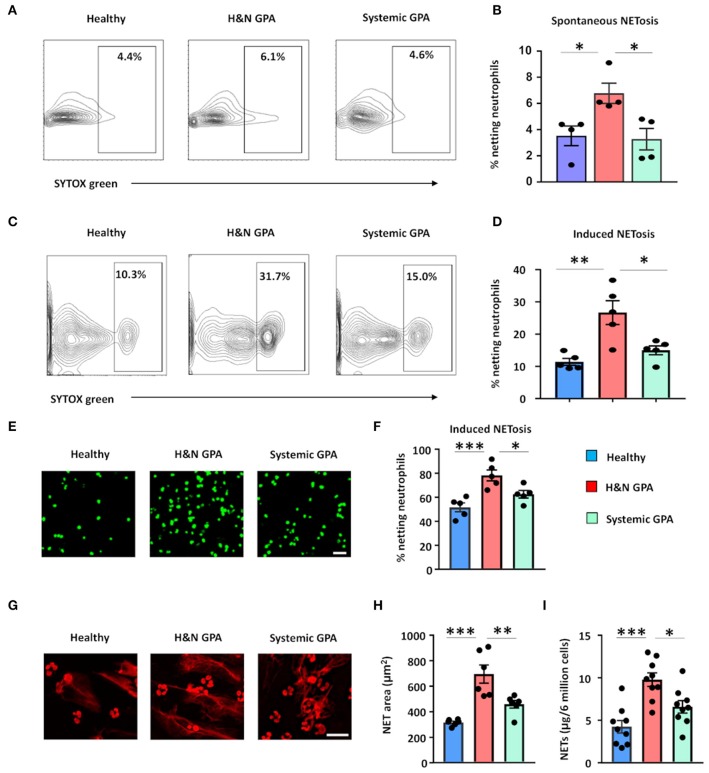
Neutrophil NET formation in patients with GPA correlates with clinical disease pattern. Blood was collected from patients with H&N GPA, systemic GPA, and age-matched healthy individuals. NET formation in isolated neutrophils was assessed by three methods. (A,B) Neutrophils were cultured for 1.5 h and spontaneous netting neutrophils were assessed as SYTOX® Green-positive cells by flow cytometry. Representative results (A) and data from four experiments (B). (C,D) Neutrophils were treated with phorbol myristate acetate (PMA; 20 ng/ml) for 1.5 h. Netting neutrophils were detected as SYTOX® Green-positive cells by flow cytometry. Representative results (C) and data from five experiments (D). (E,F) Neutrophils were activated with PMA (20 ng/ml) for 4 h and stained with SYTOX® Green. Netting neutrophils were identified by confocal microscopy. Representative images (scale bar = 100 μm) (E) and results from five experiments (F). (G,H) Netting was induced with PMA treatment (20 ng/ml; 4 h) and extracellular DNA fibers were stained by propidium iodide (PI). Representative images (scale bar = 50 μm) (G) and results from six experiments (H). (I) Measurement of DNA content in isolated NETs derived from 6 million PMA-treated neutrophils (20 ng/ml; 4 h), quantified spectrophotometrically from nine patients with H&N GPA, nine patients with systemic GPA, and nine healthy individuals. All data are mean ± SEM. (B,D,F,H,I) One-way ANOVA with post-hoc Tukey's multiple comparisons test. *P < 0.05; **P < 0.01; ***P < 0.001.